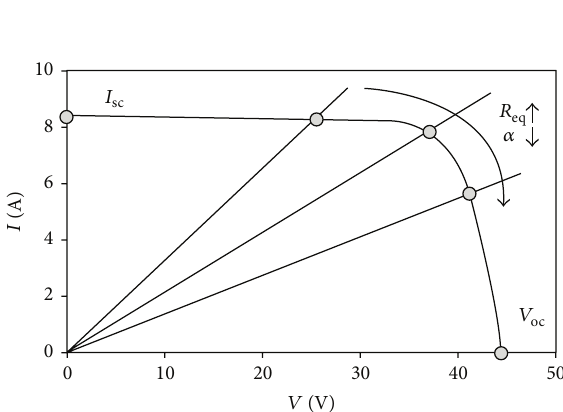
Figure 11: Effect of Boost-converter duty cycle (i.e., the equivalent resistor) variations on the operational point of a solar